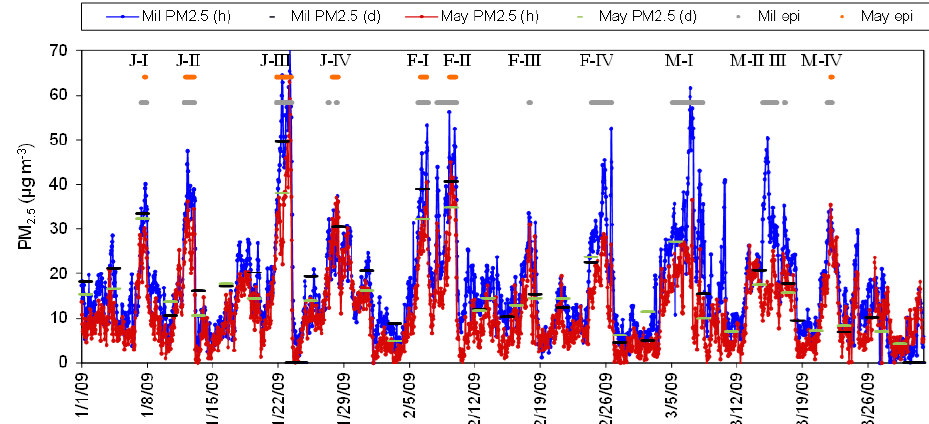
Fig. 2. Hourly and daily PM 2 . 5 . Blue (hourly) and black (24h) PM 2 . 5 concentrations are shown for Milwaukee. Red (hourly) and green (daily) PM 2 . 5 concentrations are for Mayville. Grey and orange bands indicate hours that have been designated as episode hours. Grey is for Milwaukee while orange is for Mayville. The episode number is indicated above the episode bands, with J-I being Jan-I, F-I for Feb-I, and M-I for Mar-I.